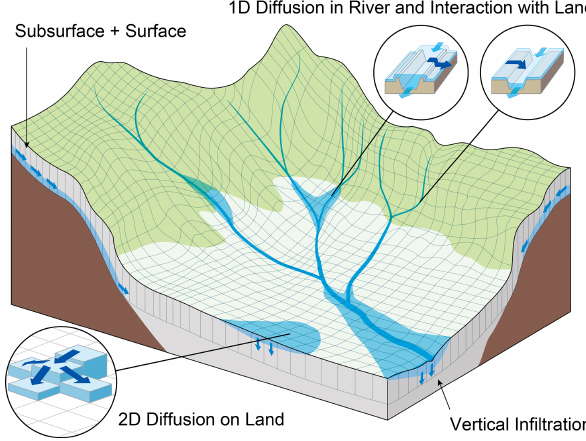
Figure 2. Schematic diagram of the rainfall–runoff–inundation (RRI) model (Sayama et al.,